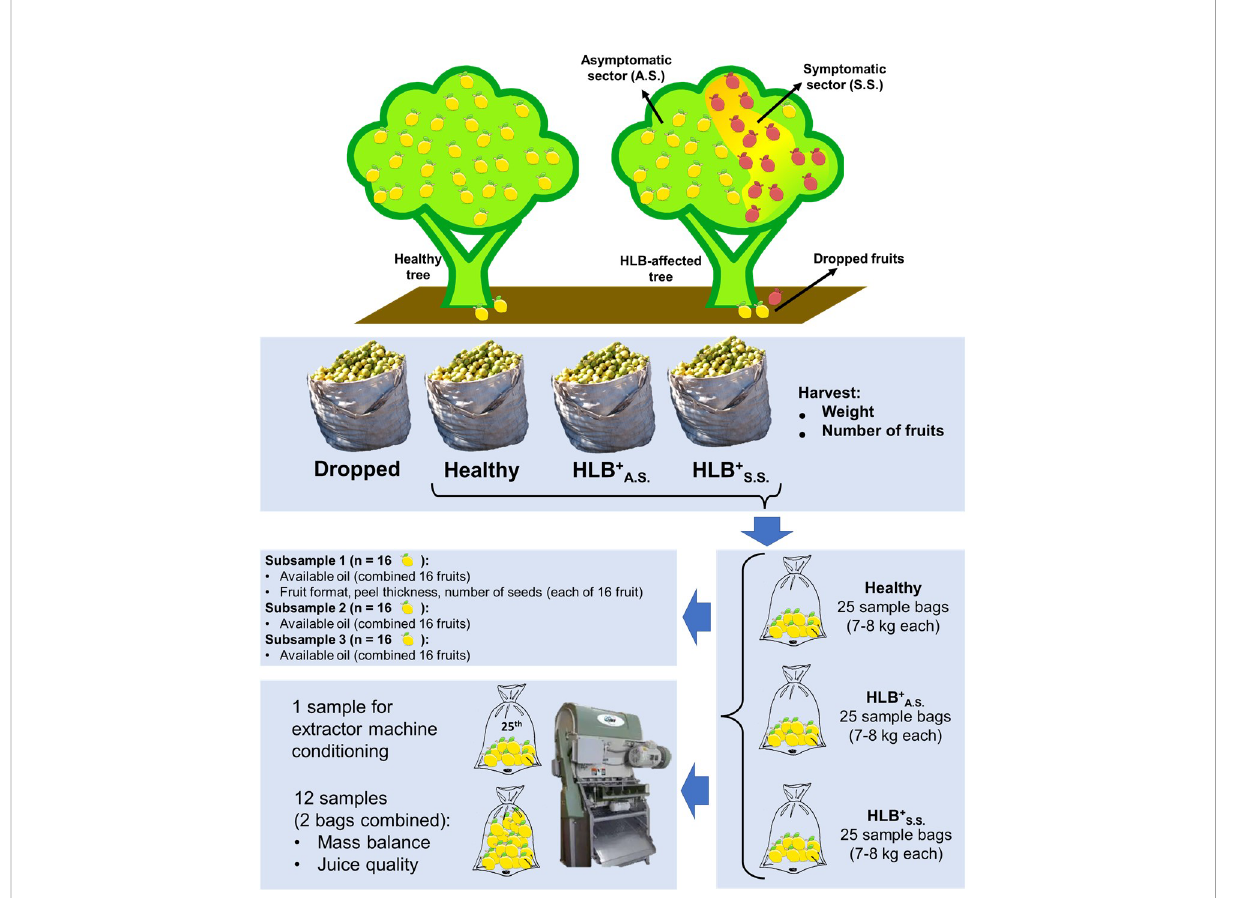
FIGURE 1 Schematic representation of the work fl ow from harvest to physical and chemical characterization of fruits harvested from healthy trees and from the asymptomatic (A.S.) and symptomatic (S.S.) sectors of the canopy of HLB-affected trees of the 5-year-old ‘ Femminello ’ lemon trees used in this